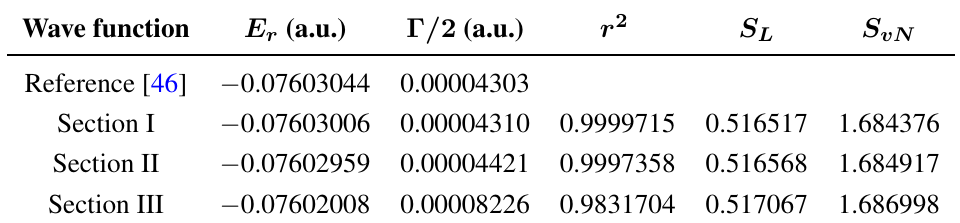
Figure 2. Fitting of density of resonance state to the Lorentzian profile. Table 1. Resonance energy, width, entanglement entropies for the doubly excited 2 s 2 1 S e state in Ps − , obtained by using N = 252 term wave